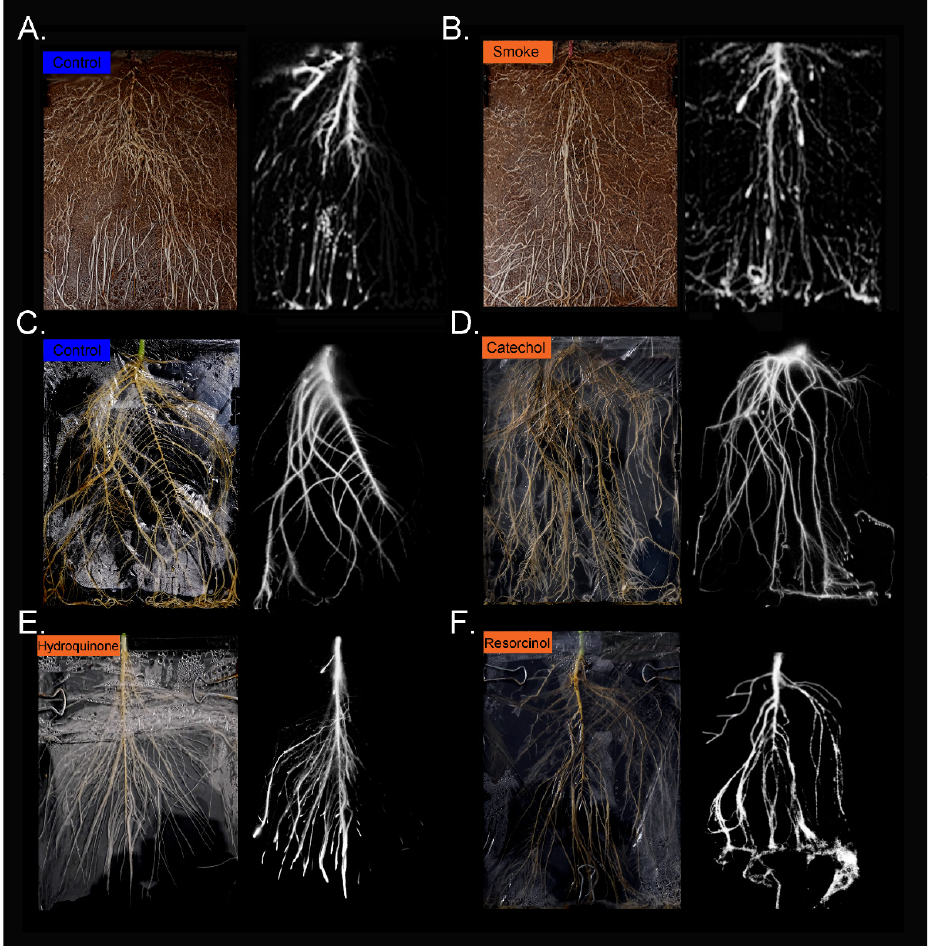
Figure 3. Root photographs with matching radiographic images showing patterns of 11 C ‐ photosyn ‐ thate allocation to sink roots. Panel ( A ): control sink roots of plants grown in soil show the charac ‐ teristic pattern of sectorial vascular connectivity. Panel ( B ): sink roots from plants grown in liquid smoke treated soil show loss of sectorial connectivity. (Panel ( C )): control sink roots of plants grown in a hydrogel matrix show similar sectorial behavior as soil grown plants. Panel ( D ): sink roots of plants grown in a hydrogel matrix treated with 150 μ M catechol show loss of sectoriality. (Panel ( E )): sink roots of plants grown in a hydrogel matrix treated with 150 μ M hydroquinone show sim ‐ ilar sectorial patterns as control plants. Panel ( F ): sink roots of plants grown a hydrogel matrix treated with 150 μ M resorcinol show loss of sectoriality.